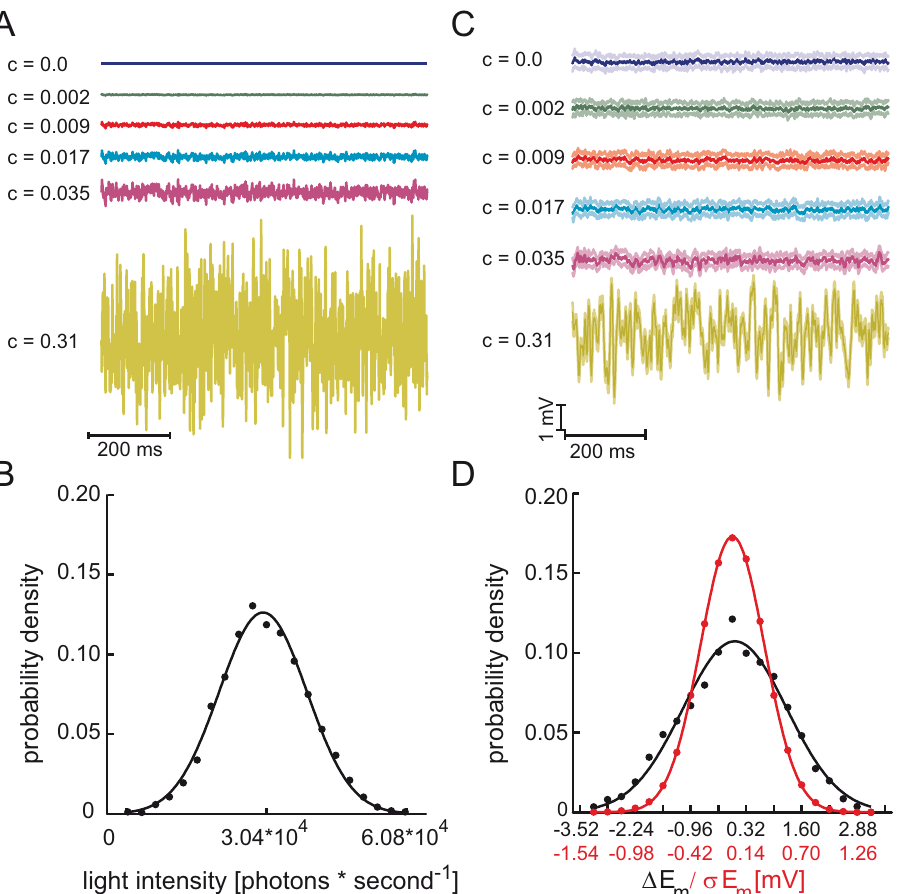
Figure 1. Stimulus and response properties. A Stimulus traces of different contrasts. The contrast, c, is defined as the ratio of standard deviation of the light intensity modulation and the mean light intensity (3.04*10 4 effective photons per second and receptor). The light intensity values were drawn from a normal distribution and the sequences were lowpass filtered with a 2nd order Butterworth filter with 256 Hz cut-off. B Probability density of the 0.31 contrast stimulus with a Gaussian fit. C Typical responses of a photoreceptor to the contrast modulation illustrated in A [averages over 25 trials (dark colors) 6 the standard deviation (light colors)]. D Probability density functions of photoreceptor response (black dots and black labels on x-axis) and the response noise (red dots and red labels on x-axis) fitted with Gaussian functions.